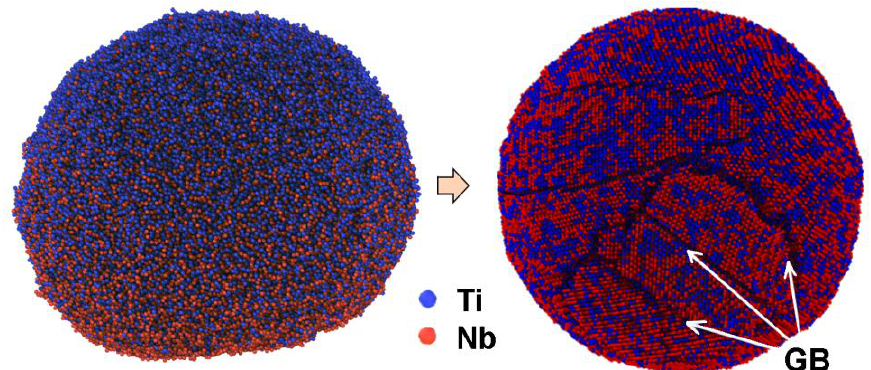
Figure 7. Initial and resulting structure of Ti-Nb solid solution obtained after MD simulation of the Ti and Nb particles’ solution solidification